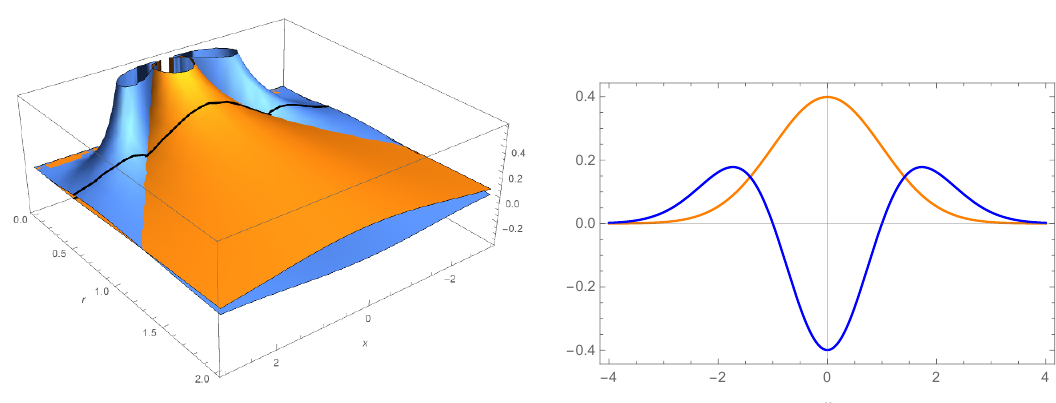
Figure 2 . In D = 1 (cid:13)at Euclidean space, the solution of the di(cid:11)usion equation (2.9) with initial condition (cid:8)(0 ; x ) = (cid:14) ( x ) is (cid:8)( r; x ) = exp[ (cid:0) x 2 = (4 r )] = plane as an orange surface (concavity upwards) in the left plot, together with (cid:31) ( r; x ) = @ 2 (blue surface, concavity downwards). The section of these surfaces at r = (cid:12)r (cid:3) = 0 : 5 (black thick line) are shown in the right